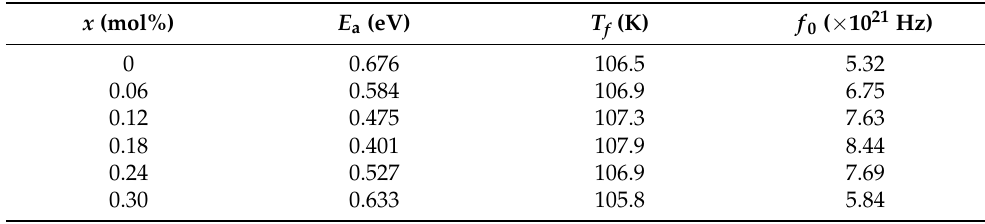
Figure 6. Plots of ln(frequency) versus 1000/ T m for the BCTZ-NY x ceramics. Table 2. Activation energy ( E a ), freezing temperature ( T f ), and pre-exponential factor ( f 0 ) of the BCTZ-NY x ceramics.